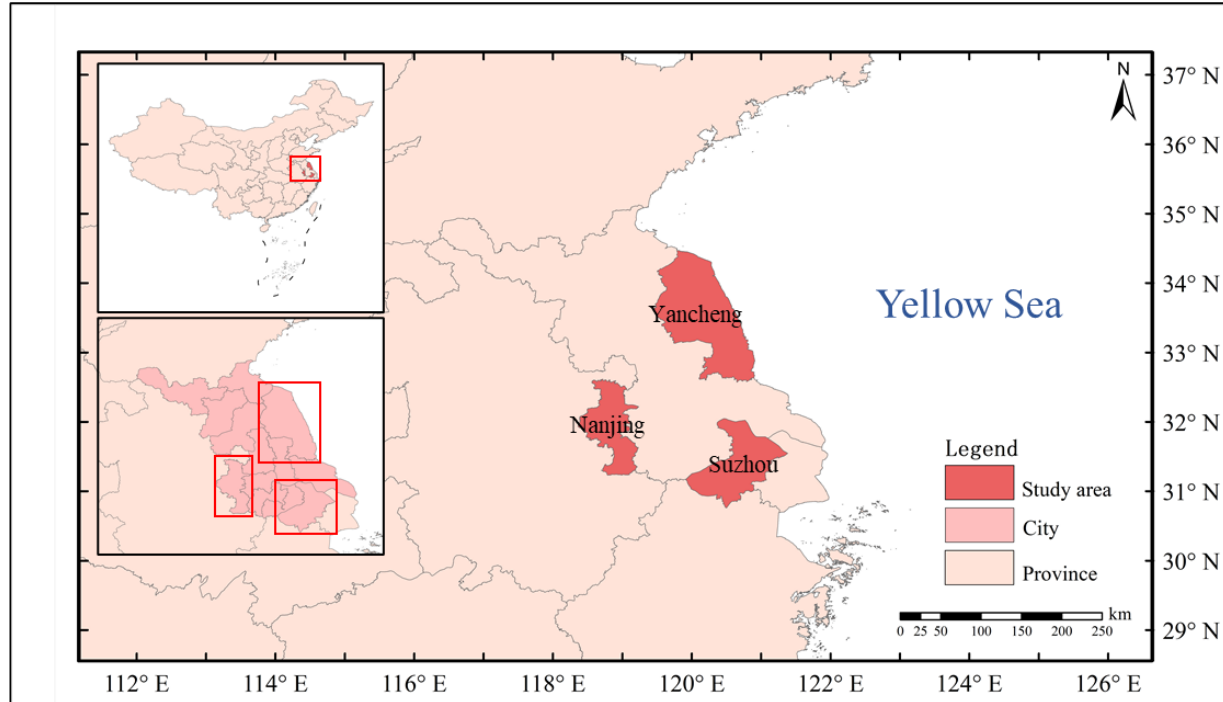
Figure 1. Location of the study area.